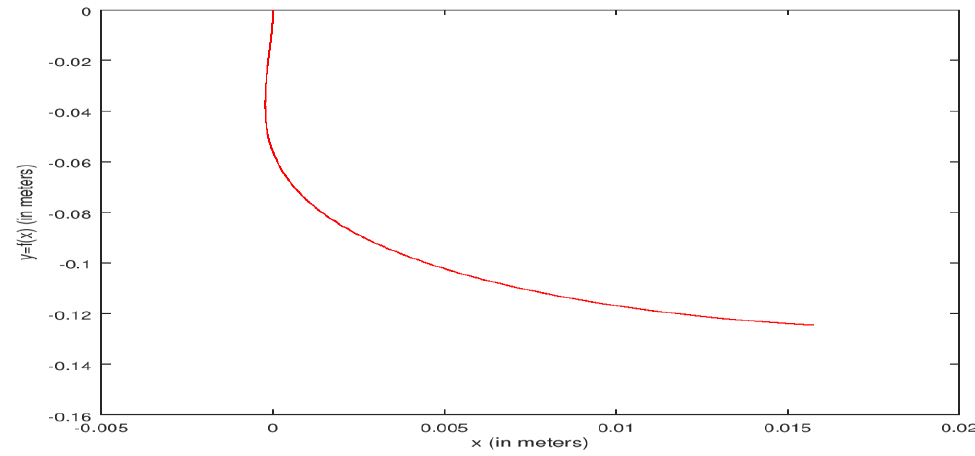
Figure 10. Feasible Vehicle Robot Trajectory.